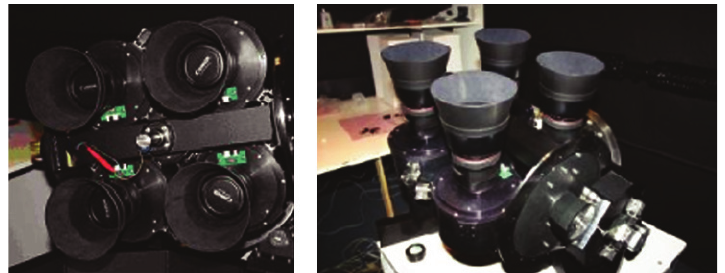
Figure 2: “Pi of the Sky” mount with 4 cameras.